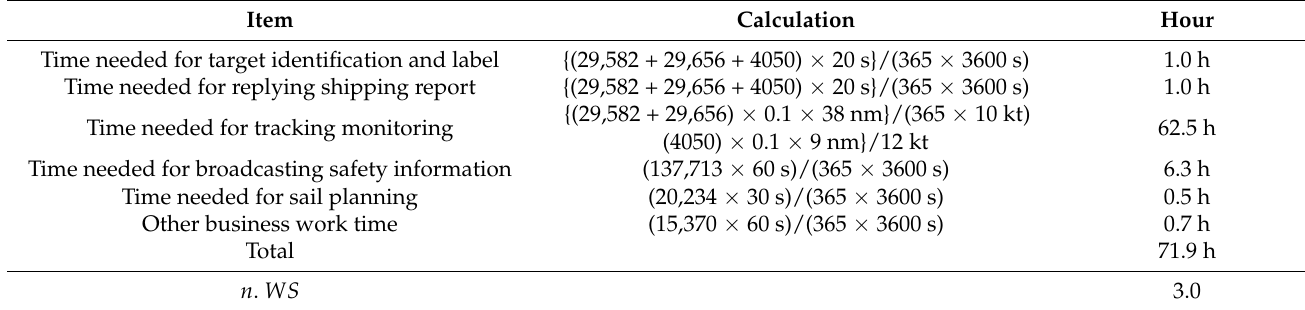
Table 6. Comparative experiment of the number of workstations of Yeosu VTS based on the Xie model [1].